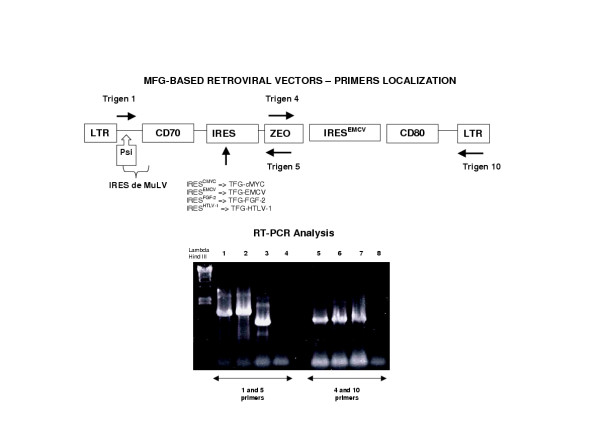
RT-PCR analysis of mRNA transcribed from the tricistronic vectors in stably transduced melanoma cells. 2A : Localization of the different primers. Figure 2B: cDNA obtained after reverse transcription was amplified using primers 1 and 5 (lanes 1 to 4) or primers 4 and 10 (lanes 5 to 8) as described in Methods. Lanes 1 and 5: RT-PCR performed on mRNA isolated from TFGFGF-2ZEO transduced cells (1819 and 1640 bp amplified respectively). Lanes 2 and 6: RT-PCR performed on mRNA isolated from TFGEMCVZEO transduced cells (1819 and 1640 bp amplified respectively). Lanes 3 and 7: RT-PCR performed on mRNA isolated from TFGHTLV-1ZEO transduced cells (1510 and 1640 bp amplified respectively). Lanes 4 and 8: RT-PCR performed on mRNA isolated from mock retroviral vector transduced cells (negative controls).